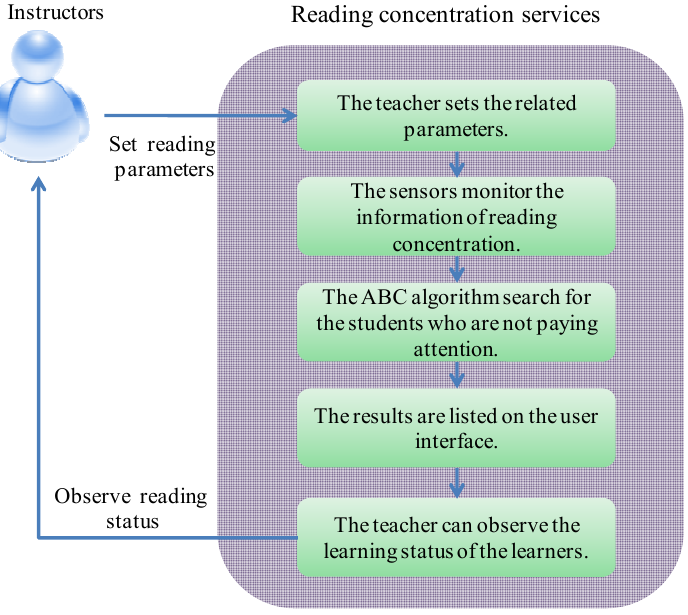
Figure 3. Procedure of the reading concentration monitoring system.